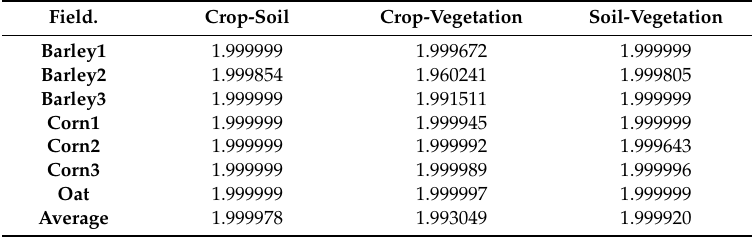
Table 8. Je ff ries–Matusita distance between the three classes in the case of the geographic object-based image analysis classification using the full GEOBIA feature list of Table